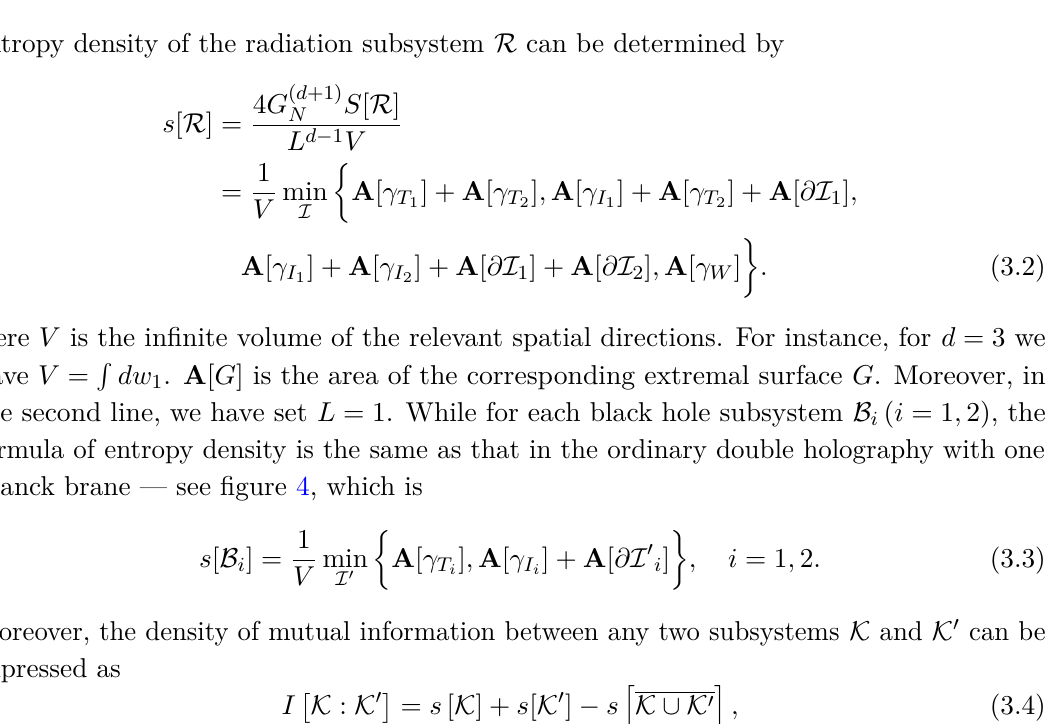
Figure 5 . The configurations of HRT surfaces in four possible phases: (a): the trivial phase; (b): the half-island phase; (c): the island phase; (d): the wormhole phase, with the HRT surfaces being plotted in